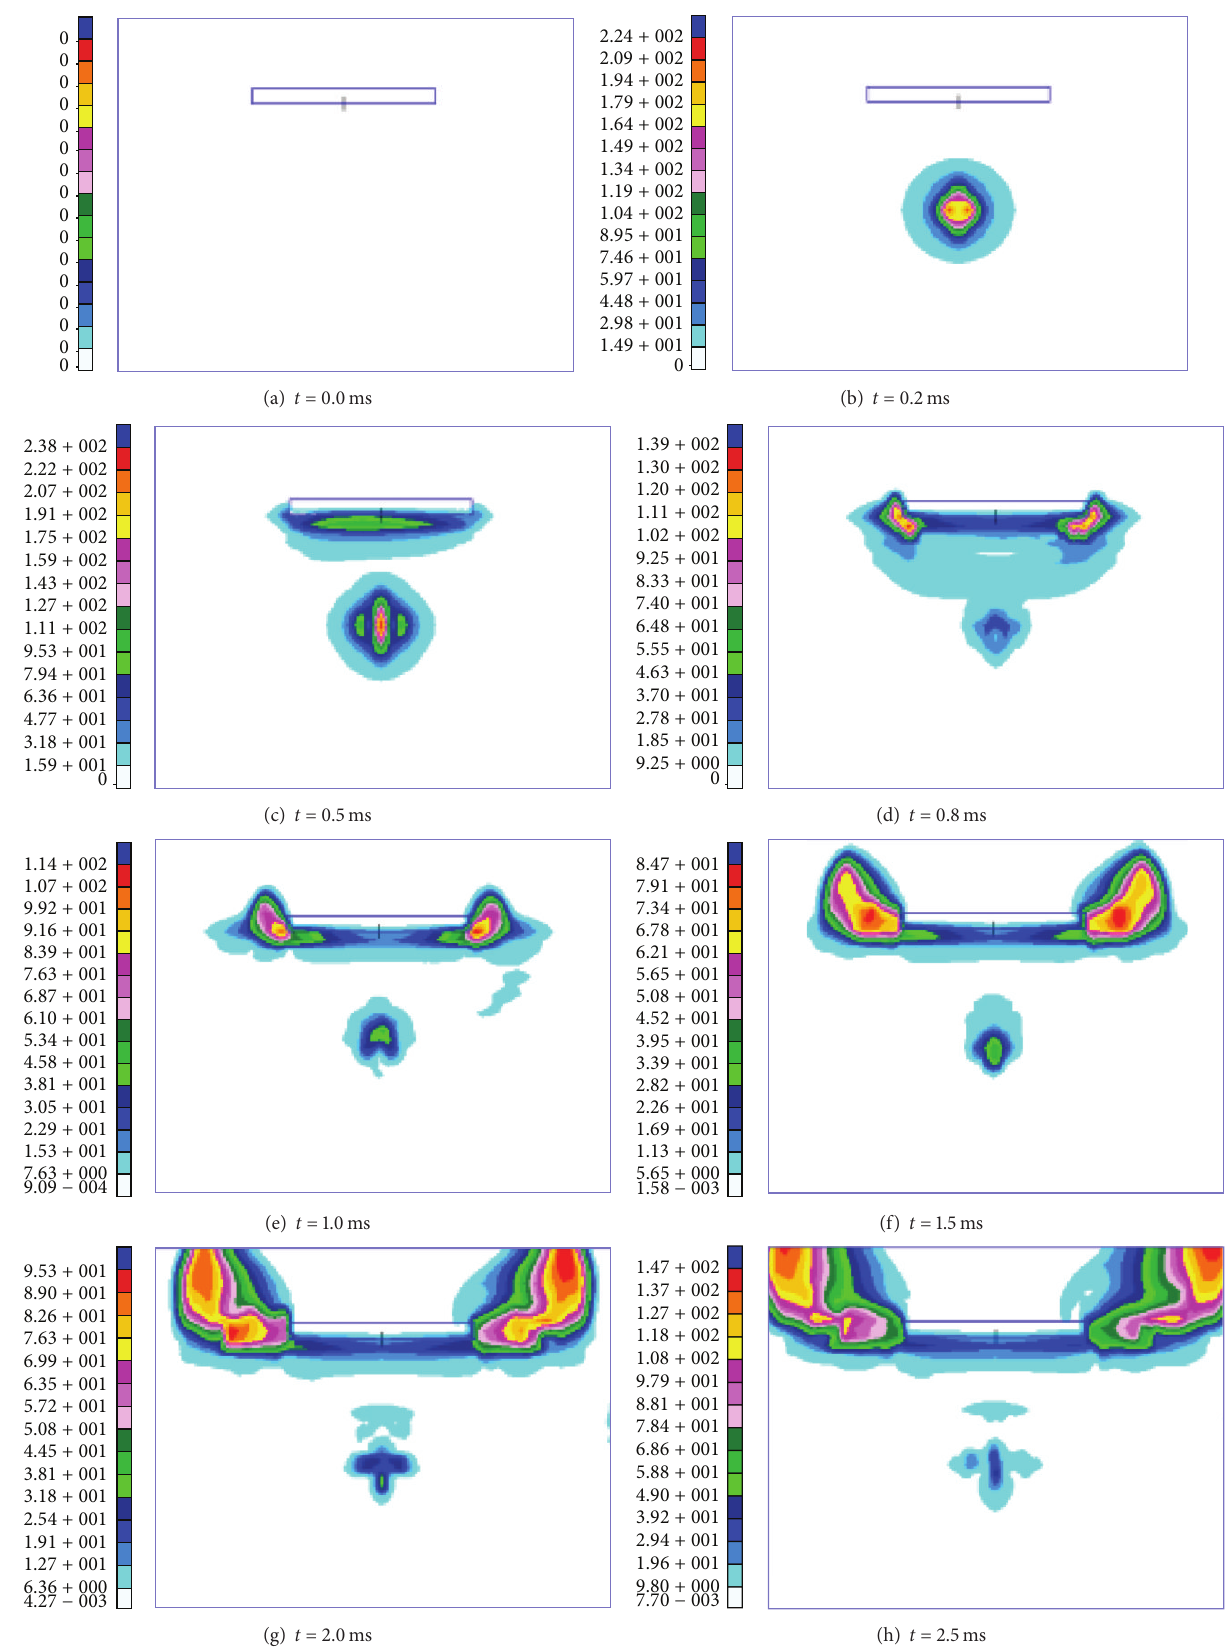
Figure 11: Fluid particle velocity contour ( W = 0.05 kg, d = 0.6